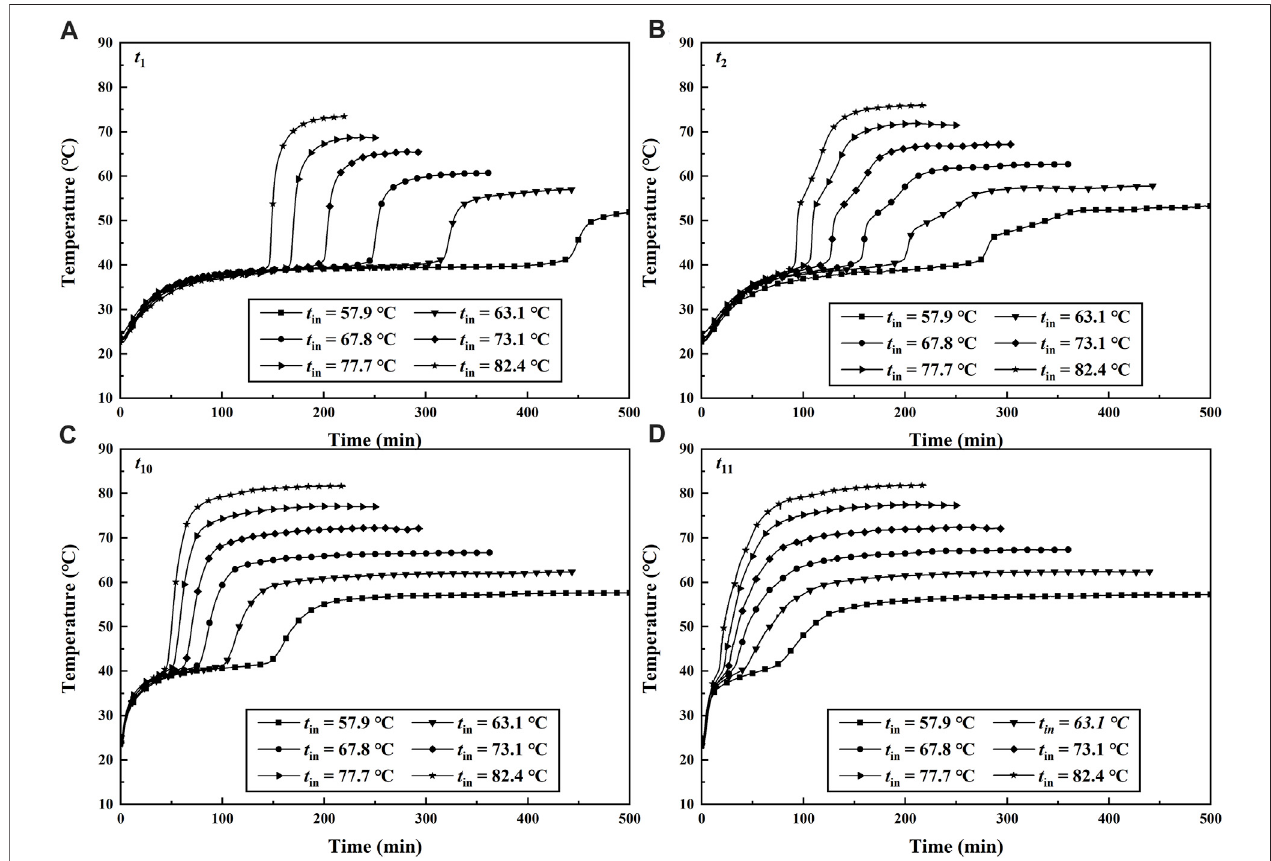
FIGURE 8 | Transient temperatures with different HTF inlet temperatures during the melting process for q v = 40 L/h, α = π /4.